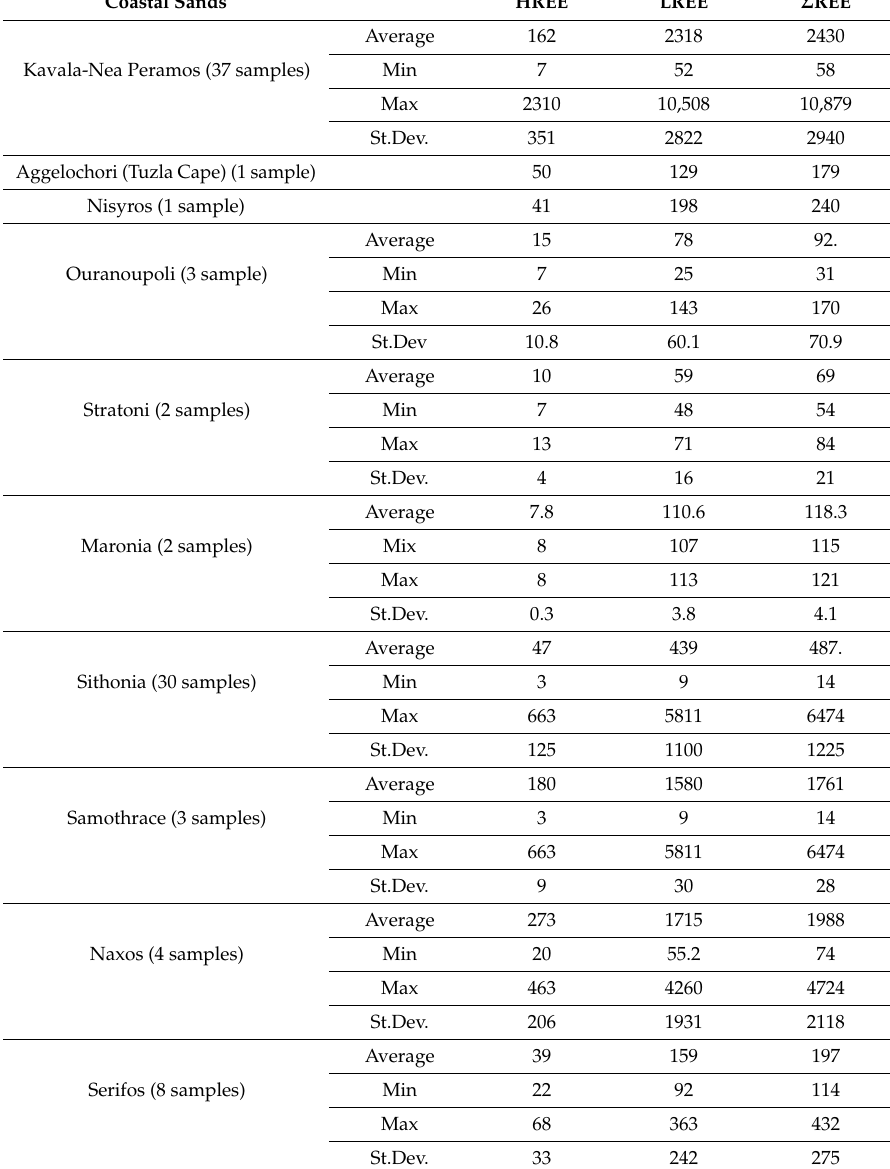
Table 1. Summary of average REE concentrations (mg / kg) in placer deposits from Greece. Coastal Sands HREE LREE Σ REE Average 162 Kavala-Nea Peramos (37 samples)